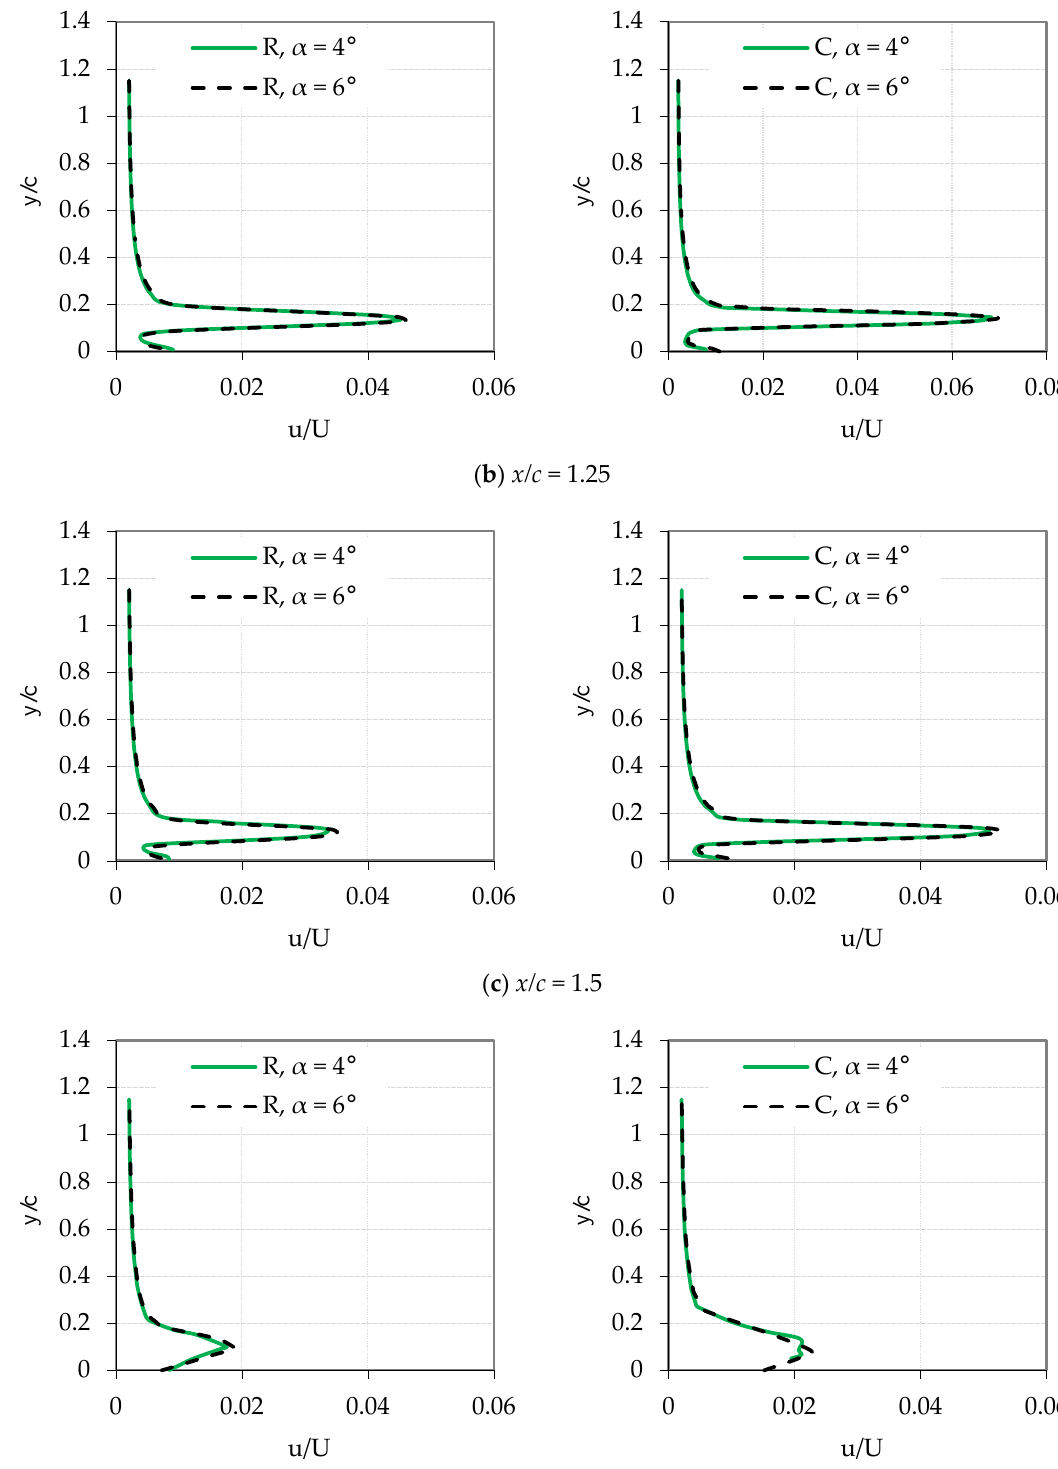
Figure 11. Turbulent intensity distribution at the middle span in the wake region behind the compound wing (C) and the rectangular wing (R) at ( a ) x/c = 1.05, ( b ) x/c = 1.25, ( c ) x/c = 1. 5, and ( d ) x/c = 2.0 for h/c = 0.15 and various attack angles ( α ).